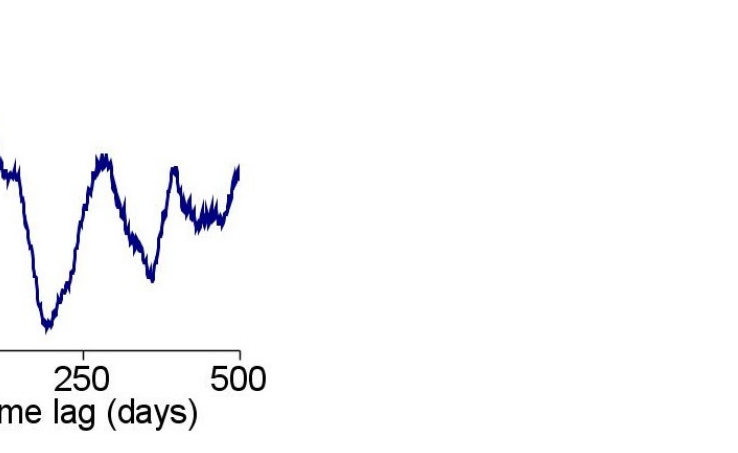
Figure 2. Time-lagged cross-correlation analysis of both filtered datasets, showing correlation rates by the phase of interval in timelines.